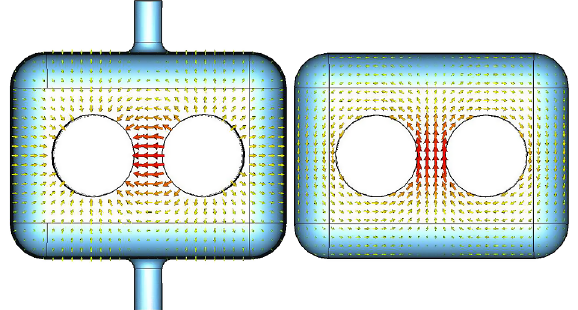
FIG. 4. Electric field (left) on the midplane and magnetic field (right) on the top plane for the fundamental deflecting mode.